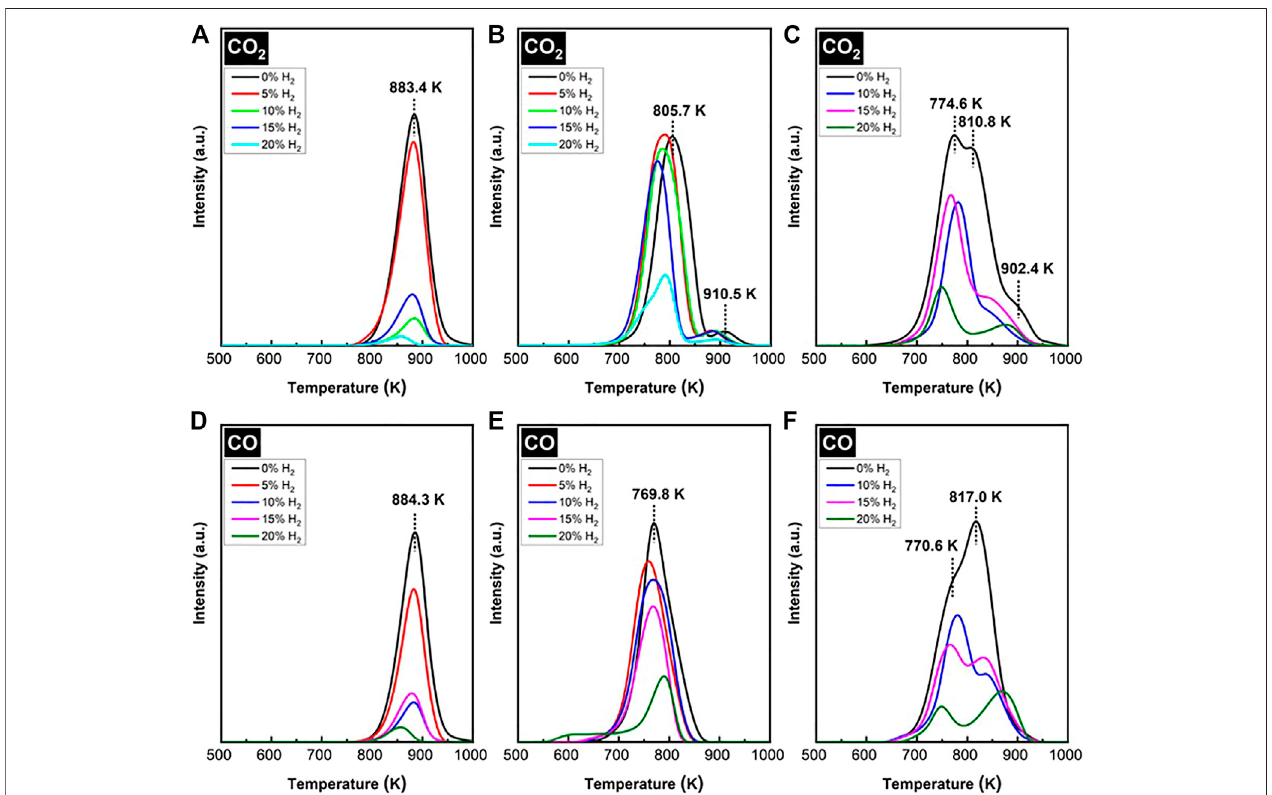
FIGURE8| CO 2 andCOevolutionpeaksinTPOpro fi lesofspentFe/SiO 2 catalyst (A and D) ,SCZOperovskiteoxide (B and E) ,and5wt%SCZOinFe/SiO 2 (C and F) at different H 2 co-feed concentrations after ToS of 3.5 h in DNMC reactions.